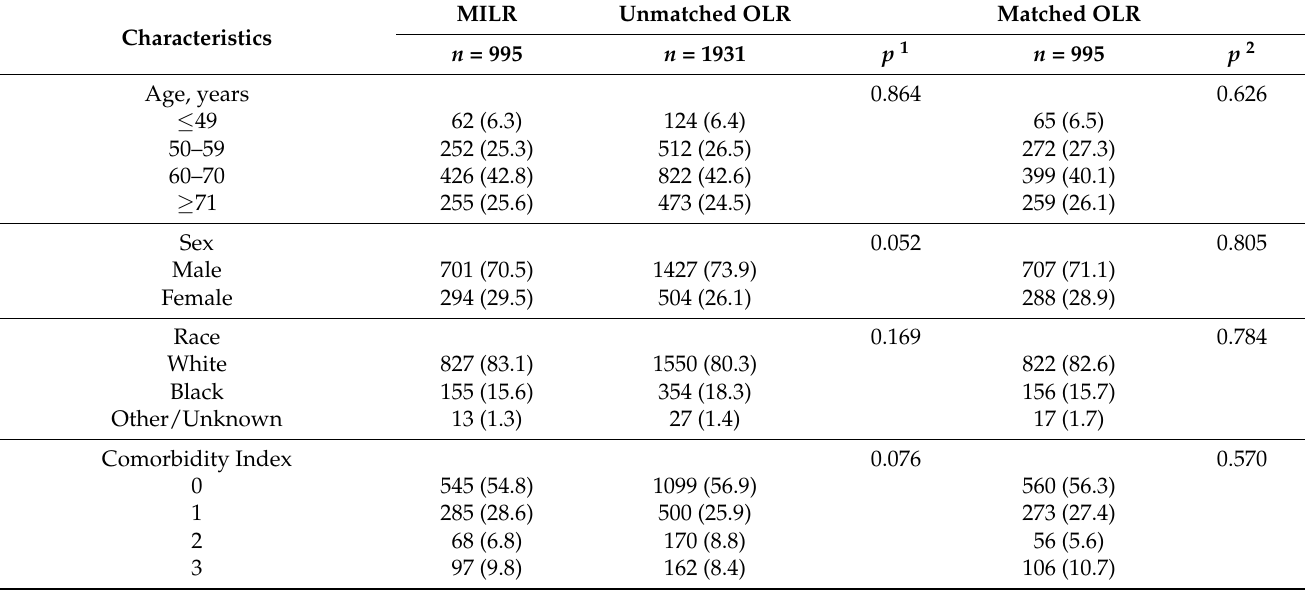
Table 1. Demographic and Clinical Characteristics of Patients with Hepatocellular Carcinoma Before and After Propensity Score